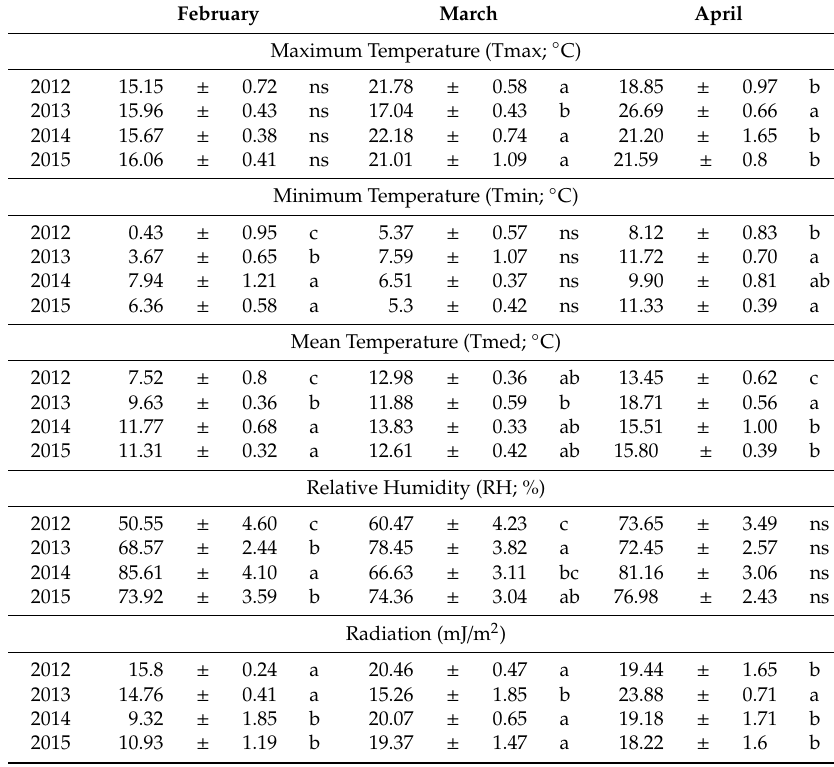
Table 1. Averaged values of the environmental variables measured under the macro-tunnel on the 10 days before fruit sampling on four consecutive years (2012–2015) and at three harvest times (February, March and April). Di ff erent letters indicate significant di ff erences between years, each month ( p <